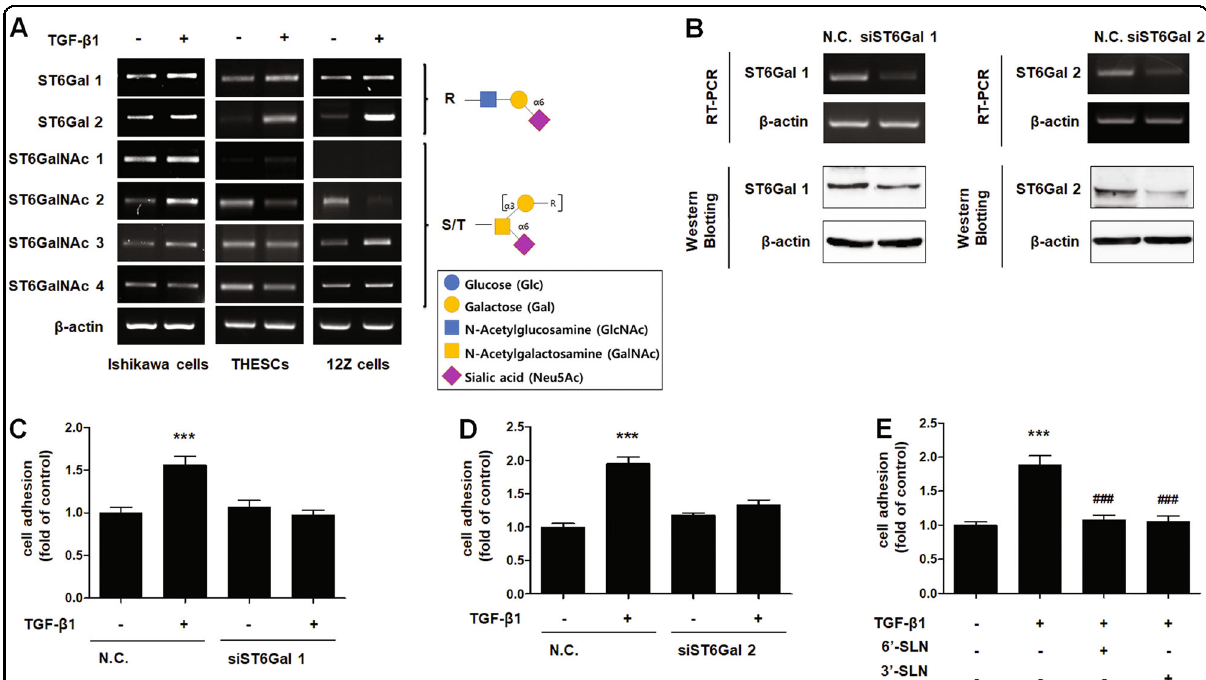
Fig. 3 TGF- β 1-induced α 2-6 sialylation is mediated by increased expression of ST6Gal1 and ST6Gal2 in endometrial cells a Ishikawa, THESCs, and 12Z cells were treated with TGF- β 1 for 24 h. Expression of α 2-6 sialyltransferases was estimated by RT-PCR. b – d Ishikawa cells were transfected with 200 nM ST6Gal1- or ST6Gal2-targeting siRNA. b Expression of ST6Gal1 or ST6Gal2 in Ishikawa cells was determined by RT-PCR or western blot analysis after 24 h of incubation. c , d siRNA-transfected Ishikawa cells were cultured with TGF- β 1 for 48 h, and then, transfected cells were labeled with CMFDA and added onto a Met-5A cell monolayer. The number of Ishikawa cells bound to Met-5A cells was calculated and is expressed as the fold-difference relative to the control (mean ± SD). e Ishikawa cells were incubated with TGF- β 1 for 48 h. 3 ʹ -SLN or 6 ʹ -SLN were applied to treat Met- 5A cells 1 h before the adhesion assay. Fluorescence-labeled Ishikawa cells were incubated at 37 °C with a Met-5A cell monolayer, and then, total number of adhered Ishikawa cells was determined. ** p < 0.01 and *** p < 0.001 compared with the control group. # p < 0.05 compared with the